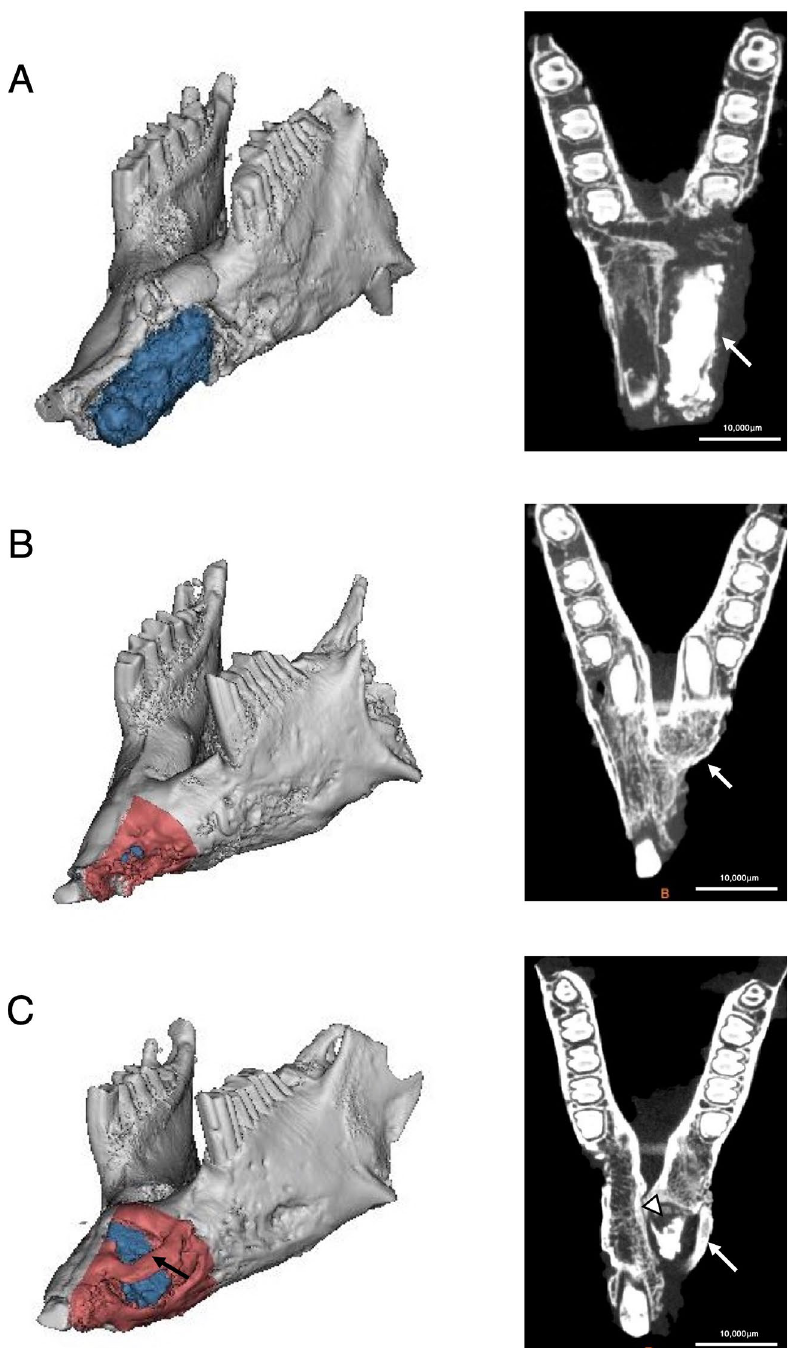
Figure 2. Micro-computed tomography (CT) assessment of regenerated bone formation. Micro-CT data and its three- dimensional (3-D) reconstructed images were used to differentiate new bone formation and remnant scaffold material at 12 weeks after the procedure. ( A ) In group A (control), an extensive remnant scaffold material (blue) is present in the left panel. In the axial section image, the scaffold is identified as a high radiodensity structure in the right panel (white arrow). ( B ) In group B (rhBMP-2), the scaffold is not detectable (left panel). No radiodensity structure corresponding to the scaffold is detectable in the axial section image (right panel). At the same time, minimal bone formation was identified (white arrow). ( C ) In group C (HMGB-1), extensive callus formation (black arrow) was found surrounding the remnant scaffold (left panel). The axial section image shows the bridging formation (white arrow) and the remnant scaffold being absorbed and replaced by a lower radiodensity structure (white arrowhead, right panel). The remnant scaffold is identified in blue and newly formed bone in red in the 3-D reconstructed images. The images in ( A ) were retrieved from specimen ID 18–3, ( B ) from 18–13, and ( C ) from 18–5. Materialise MIMICS software version 21.0 (https:// www. mater ialise. com/ en/ medic al/ mimics- innov ation- suite/ mimics) was used for the analysis. Individual axial micro-CT images of specimens are presented in Supplementary Fig.